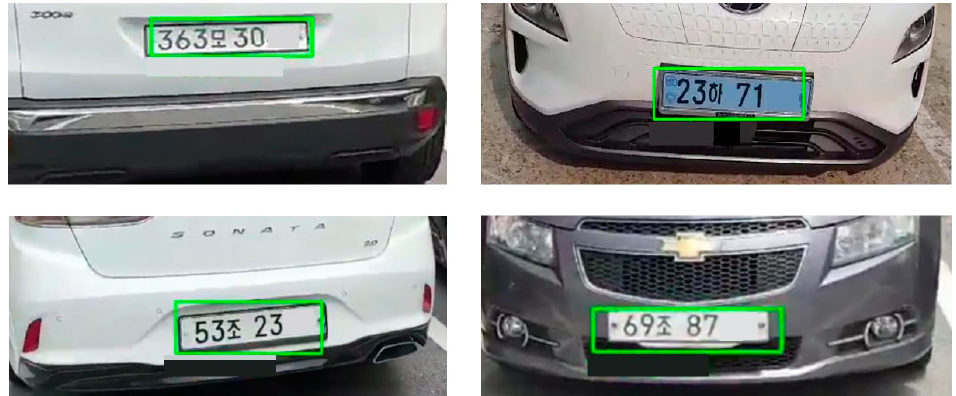
Figure 10. Examples of plate detection results. Two characters were masked due to privacy policies.